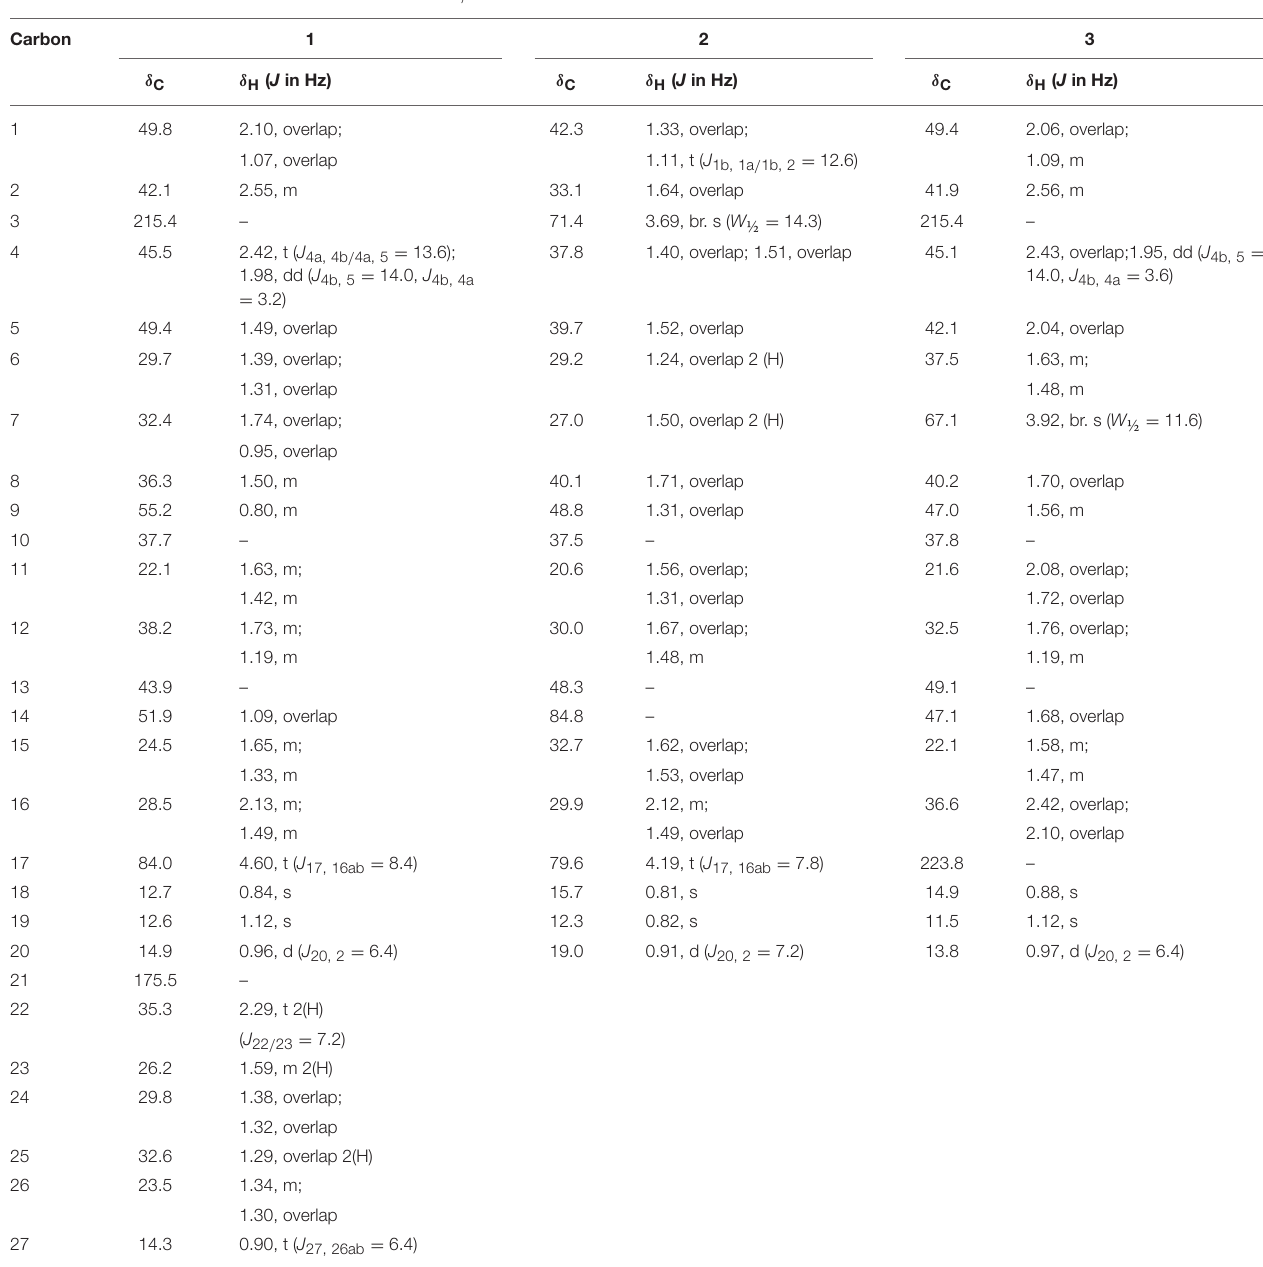
TABLE 1 | 13 C- and 1 H-NMR chemical shift data ( J and W 1 / 2 in Hz) of compounds 1–3 ( δ ppm).